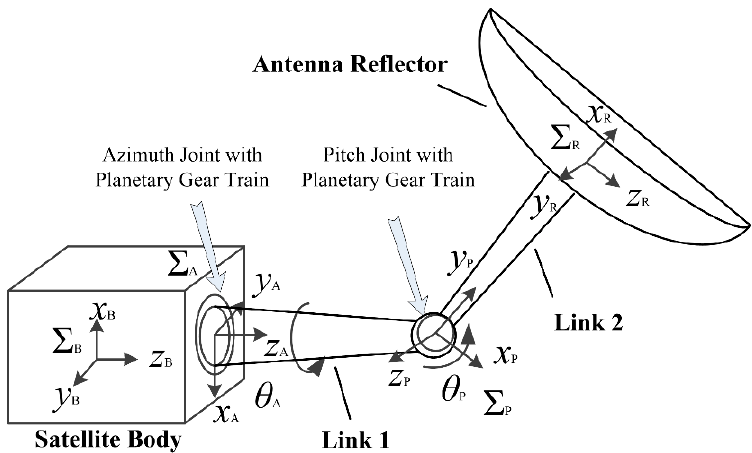
Figure 4. The dynamic model of the satellite antenna system.